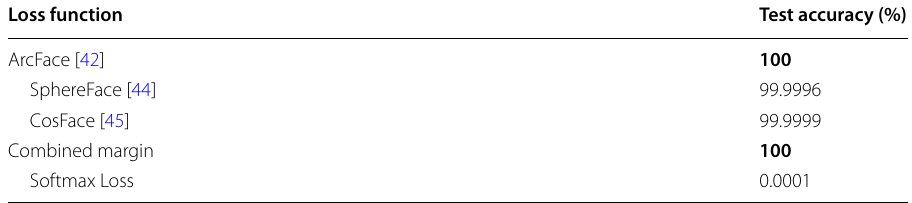
Bold indicates best result